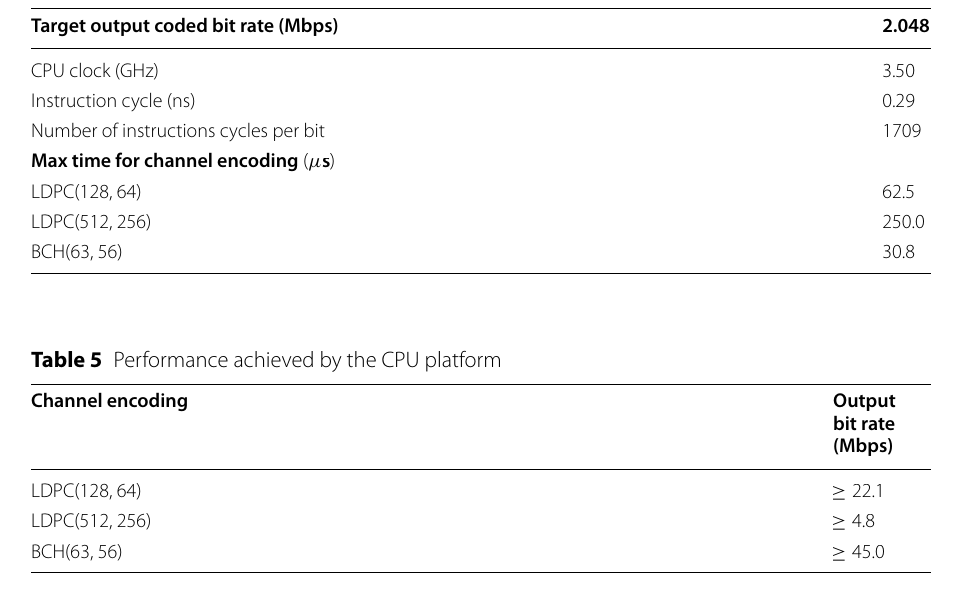
Table 4 Target performance considering only the encoder